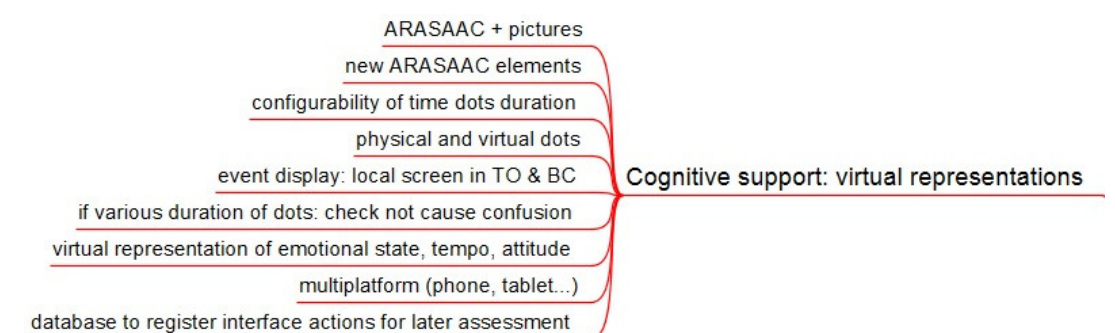
Figure 1. Services requirements for virtual representations.